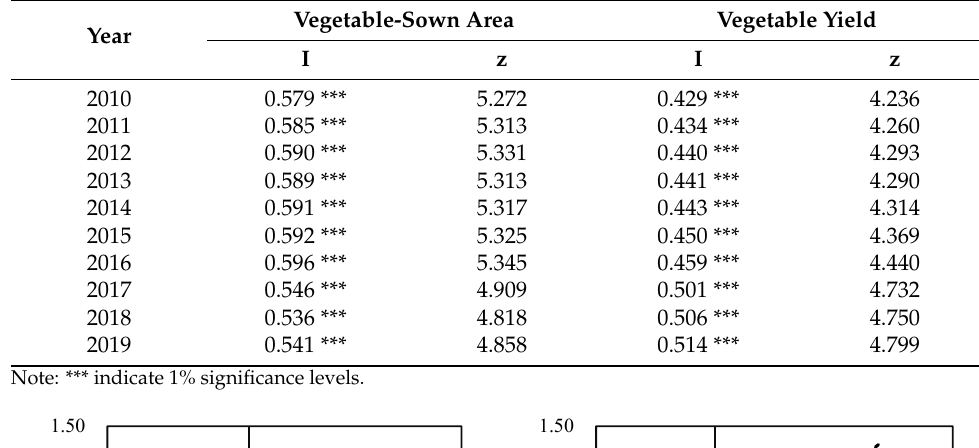
Table 3. Moran’s I index of the Chinese vegetable industry.